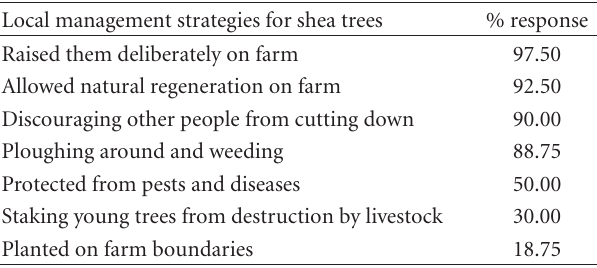
Table 2: Local management strategies for shea trees by farming households in Amuria district, eastern